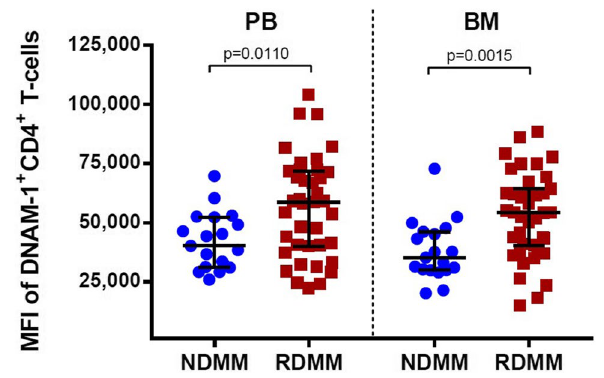
Fig. 2 Median fluorescence intensity of DNAM-1 on DNAM- 1 + CD4 + T-cells from PB and BM. PB peripheral blood; BM bone marrow, NDMM newly diagnosed multiple myeloma patients; DRMM = daratumumab-refractory multiple myeloma patients